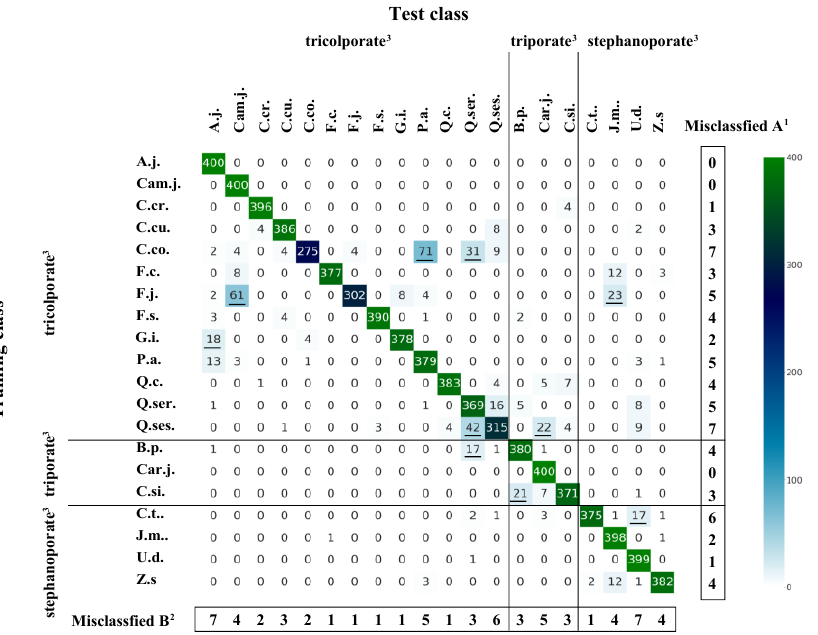
Figure 4. Heatmap of misclassification patterns according to tree species and pollen type. Results were obtained using the GoogLeNet algorithm with data augmentation using focal point E and 200 epochs. Values are the sums of 10 simulation results. Underlining indicates the 10 most frequent cases. 1 Number of tree species misclassified, 2 number of times a species was misclassified as a positive example of another tree species, 3 pollen types (Morita [26]).